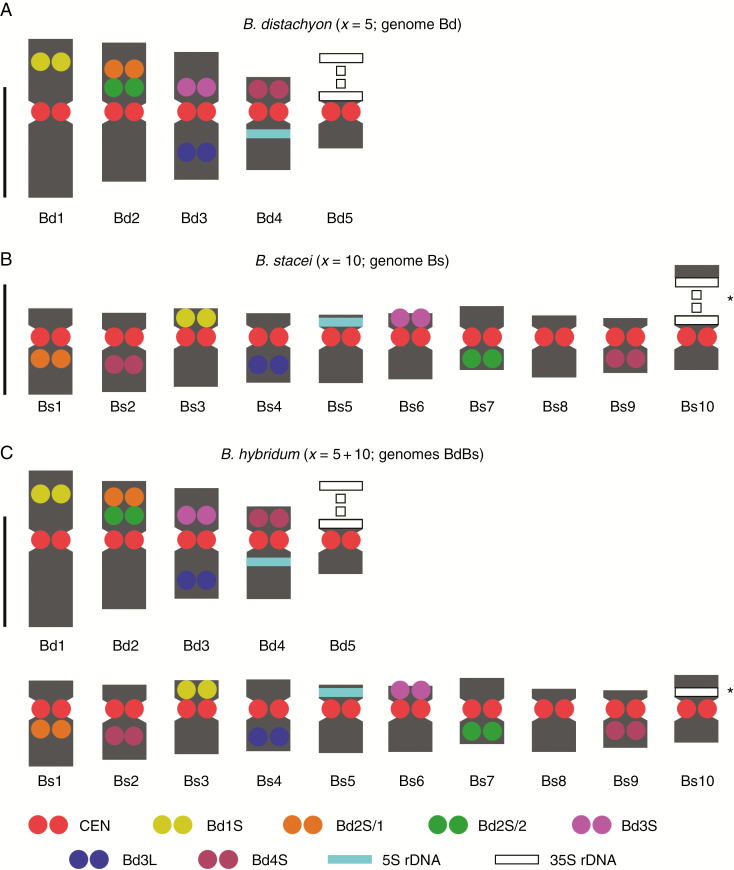
Ideograms of B. distachyon Bd21 (A), B. stacei ABR114 (B) and B. hybridum ABR113 (C) somatic metaphase chromosomes. The ideogram in (C) represents the sum of those in (A) and (B) except for some minor variation regarding Bs10 chromosomes, which is connected with a difference in condensation of their 35S rDNA loci (marked by asterisks). The lengths and shapes of the chromosomes in the diagrams are based on the mean morphometric parameters from Supplementary Data Tables S1–S3. Scale bars = 2.5 µm.